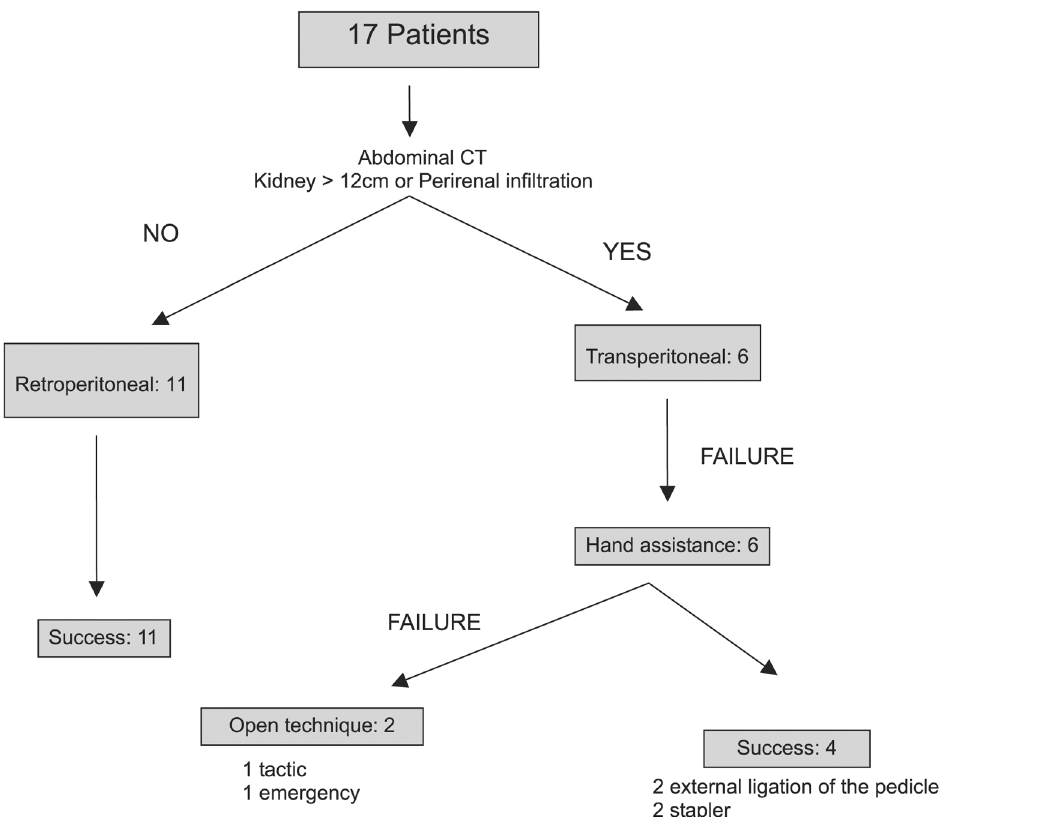
Figure 1 – Patient distribution according to the criteria adopted for staged laparoscopic